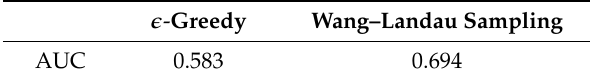
Table 1. Ablation study: Effectiveness of Wang–Landau sampling for reinforcement learning-based visual tracking.